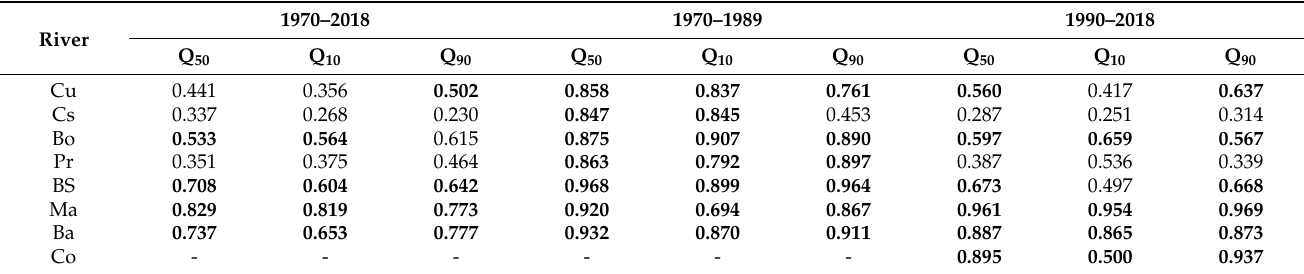
Table A4. KGE of the third-order MR models predicted by Niño 3.4 and DMI in SON a set in three different periods. The values higher than 0.5 are bolded, indicating good model